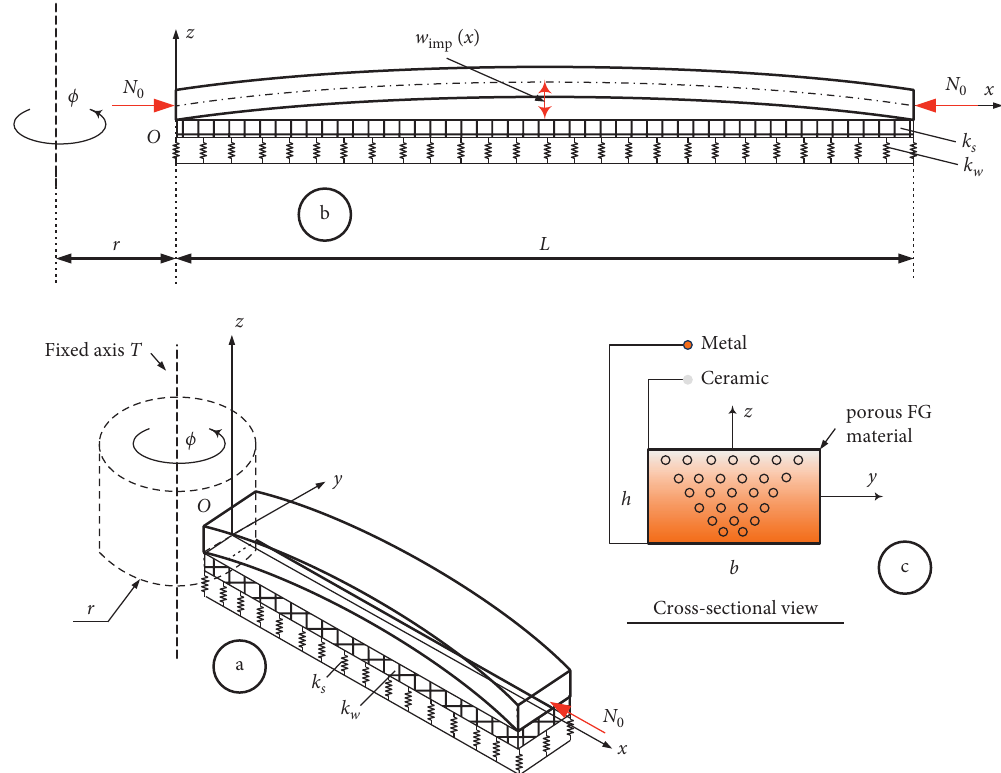
Figure 1: A rotating porous FGM beam resting on an elastic foundation (a) General perspective. (b) xOz perspective. (c) Cross-sectional